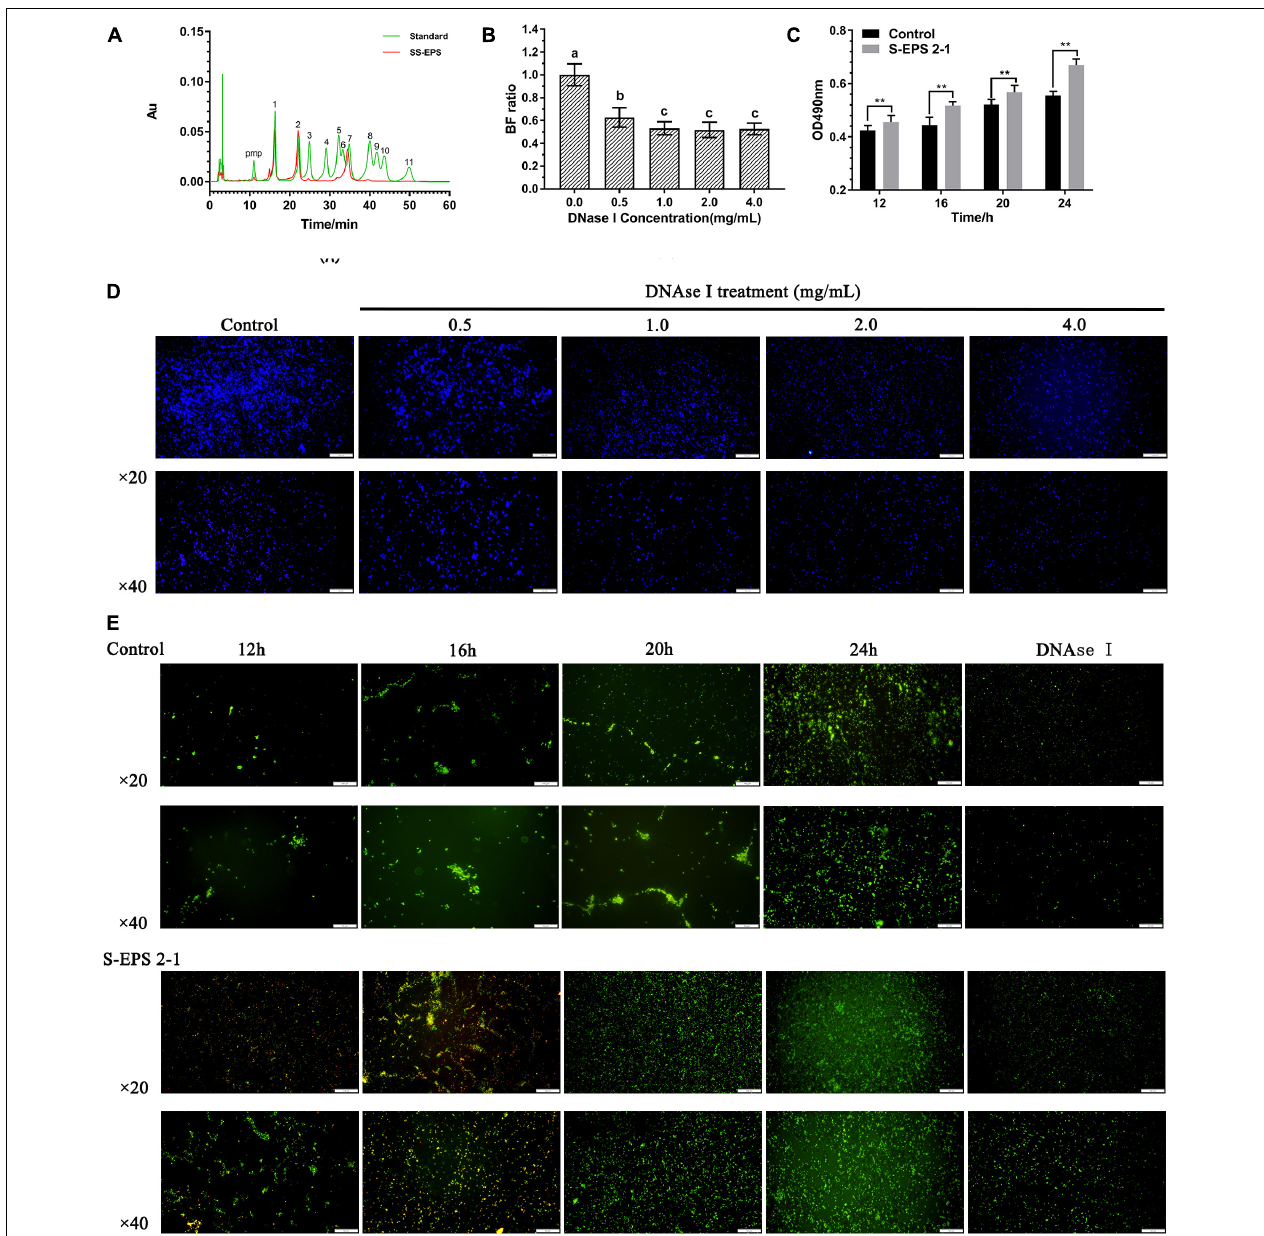
FIGURE 8 | (A) HPLC chromatogram of SS-EPS and standards with peaks as follows: (1) Man, (2) Rha, (3) GlcA acid, (4) GalA, (5) GalN, (6) GlcN, (7) Glc, (8) Gal, (9) Xyl, (10) Ara, and (11) Fuc. (B) Biofilm formation ratio of S. flexneri after treated with different concentrations of DNase I for 1 h. (C) Polysaccharide content in the extracellular polymer matrix at different culture time points. (D) Fluorescence microscopy image of S. flexneri biofilm formation after treated with different concentrations of DNase I for 1 h; the biofilm was stained by calcofluor white stain. Scale bars indicate 100 µ m (20 × ) and 50 µ m (40 × ). (E) Fluorescence microscopy image of S. flexneri biofilm formation after treated with 4 mg/ml S-EPS 2-1 for 12, 16, 20, and 24 h; the biofilm was stained by Gelgreen stain. Scale bars indicate 100 µ m (20 × ) and 50 µ m (40 × ). “**” indicated the significant difference, p < 0.01. The different lowercase letters on the column indicated the significant difference, p <